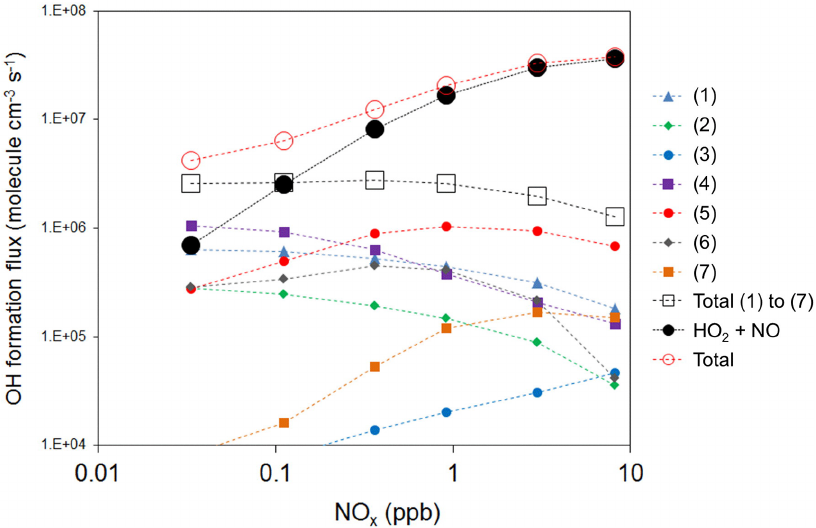
Figure 11. Comparison of daylight-averaged fluxes through the newly implemented OH regeneration routes with that through the reaction of HO 2 with NO. (1) First-generation chemistry of C536O2 and C537O2 (Fig. 3), dominated by their 1,4 H shift reactions; (2) first-generation 1,5 H shift reactions (i.e from ISOPBO2, ISOPDO2 or C524O2) (Figs. 2, S3); (3) first-generation chemistry of C526O2 and C527O2 (Figs. S1, S2), dominated by their 1,4 H shift reactions; (4) reaction sequence following the rapid photolysis of C5HPALD1 and C5HPALD2 (Fig. 9), including subsequent rapid photolysis of HMAC and HVMK (Sect. 2.2.7); (5) higher-generation 1,4 H shift isomerisation reactions (e.g. from MACRO2, C57O2 and C58AO2) (Figs. 6, 8); (6) RC(O)O 2 + HO 2 reactions (Sect. 2.3); and (7) HCOCO + O 2 (i.e. included in the update to glyoxal chemistry, Sect